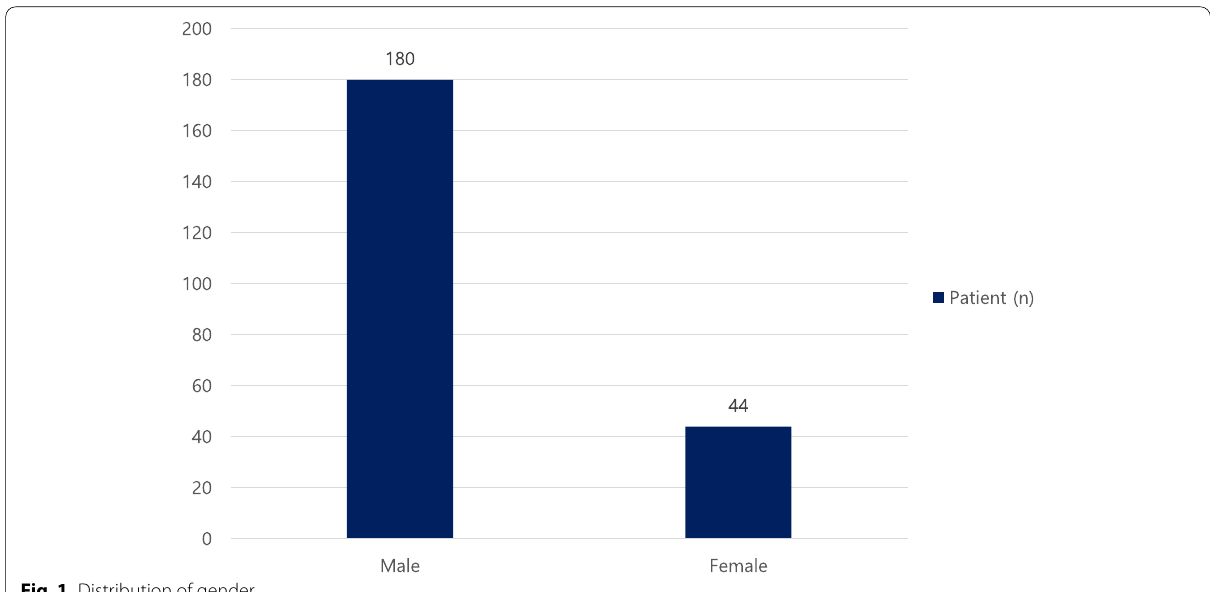
Fig. 1 Distribution of